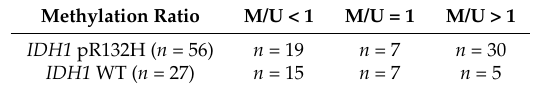
Table 3. Assessment of the methylation status based on the comparison between the methylated (M) and unmethylated (U) amplicons for each of the 83 randomly selected DNA samples.